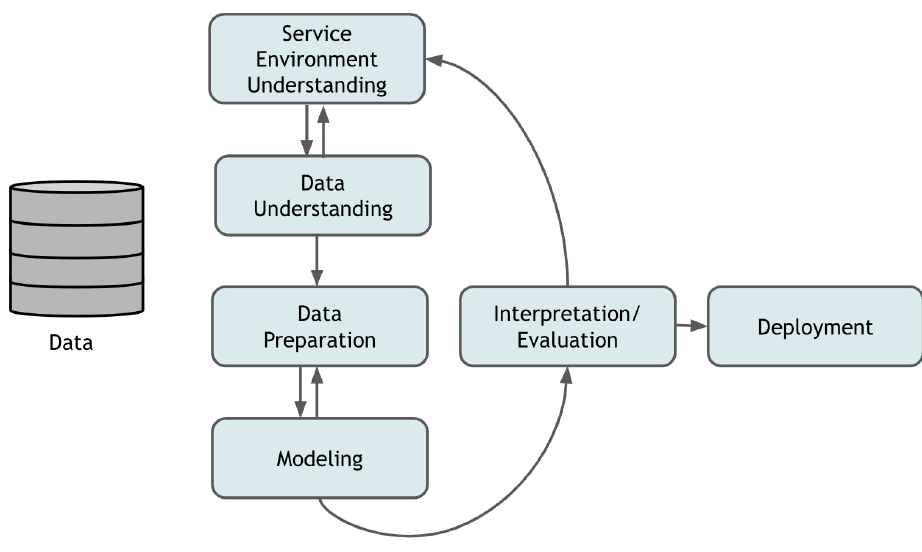
Figure 12. Typical data mining process.